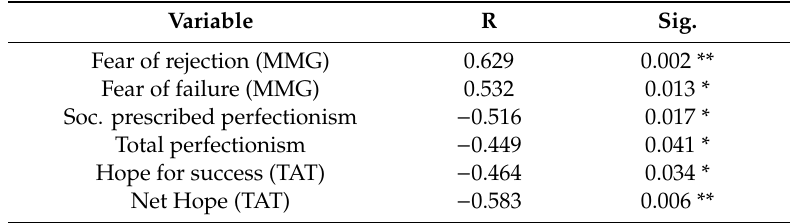
Table 4. Correlations between fear of power and other variables in EH